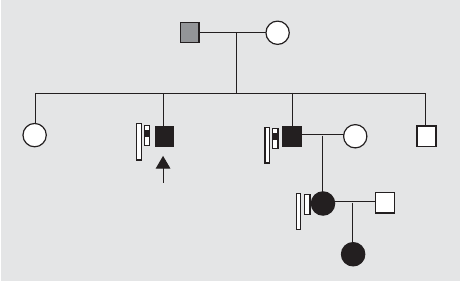
Figure 1. Genealogy of the indi- viduals affected by CMT and the segregation of the 17p duplica- tion and the Thr(118)Met substi- tution. Squares and circles: black = affected, gray = prob- ably affected, white = normal; short rectangle: normal allele; short rectangle with a black dot: allele with C(402)T nucleotide substitution; long rectangle: 17p11.2 duplication; black ar- row: